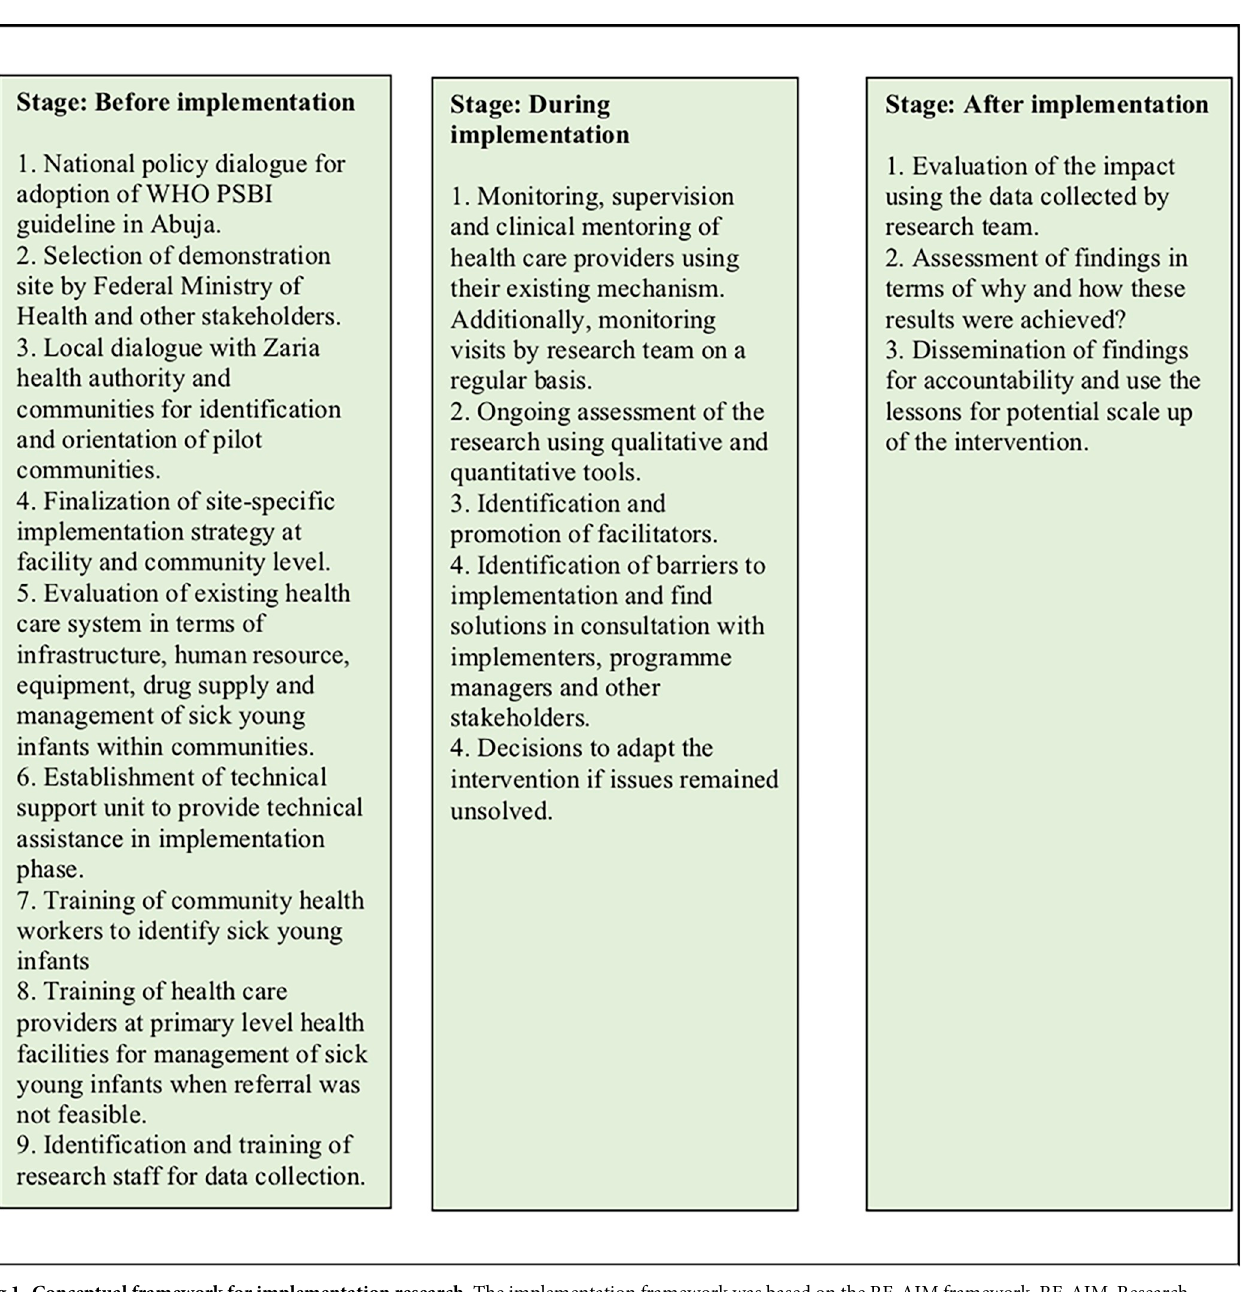
Fig 1. Conceptual framework for implementation research. The implementation framework was based on the RE-AIM framework. RE-AIM, Research Effectiveness Adoption Implementation Maintenance.